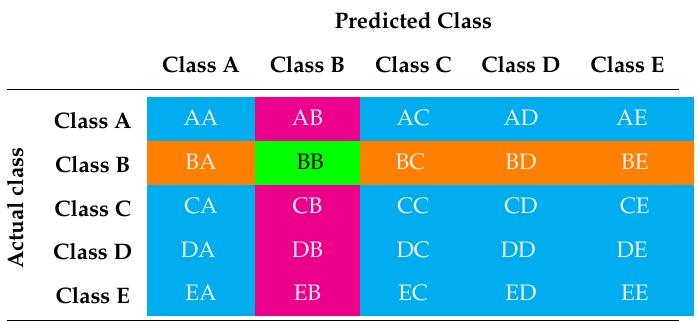
The classification results TP j , FP j , FN j and TN j for j = 1, . . . , 5 that correspond to classes A, B, C, D and E in Table 4, respectively, are computed